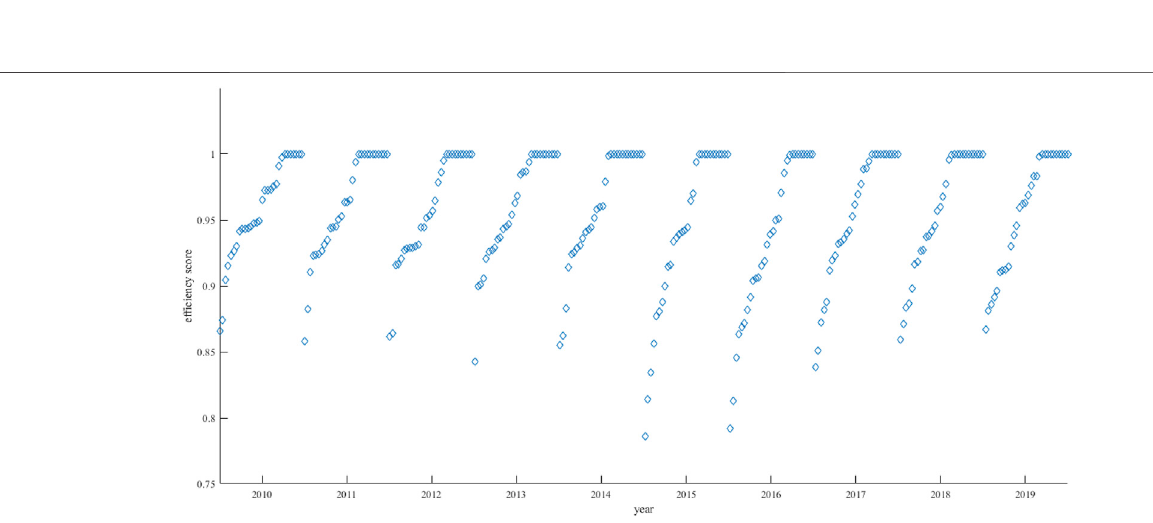
FIGURE 2 | Environmental ef fi ciency of the power sector during 2010 –